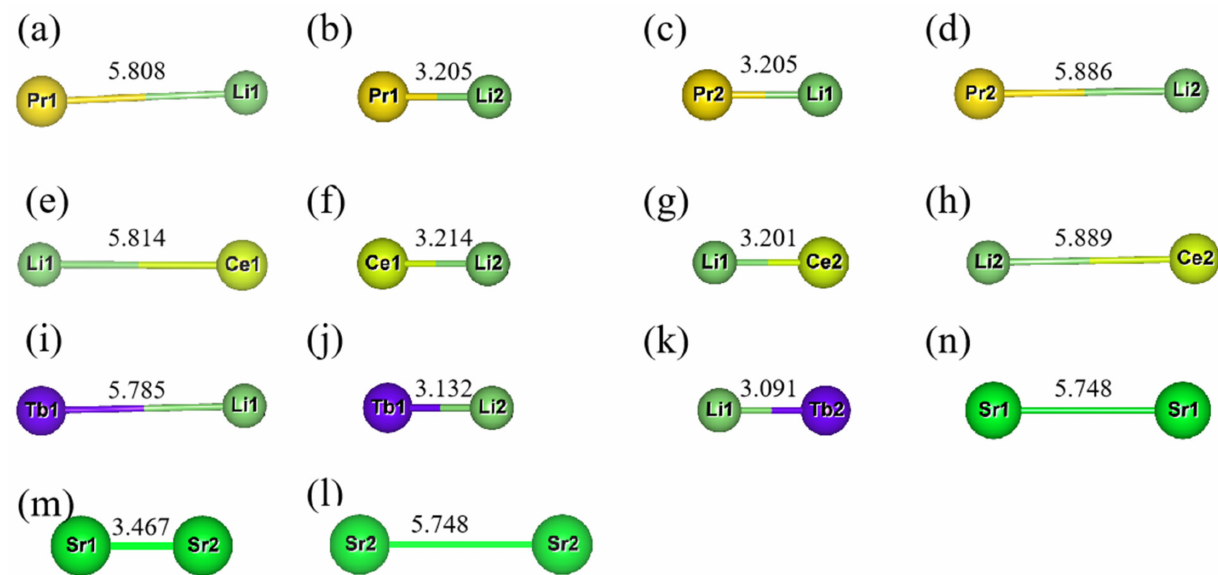
Figure 2. The distance change after Ln 3+ and Li + replace Sr 1 and Sr 2 in doped Sr 2 Si 5 N 8 ( a – k ) Pr Sr1 Li Sr1 -Sr 2 Si 5 N 8 , Pr Sr1 Li Sr2 - Sr 2 Si 5 N 8 , Pr Sr2 Li Sr1 -Sr 2 Si 5 N 8 , Pr Sr2 Li Sr2 -Sr 2 Si 5 N 8 , Ce Sr1 Li Sr1 -Sr 2 Si 5 N 8 , Ce Sr1 Li Sr2 -Sr 2 Si 5 N 8 , Ce Sr2 Li Sr1 -Sr 2 Si 5 N 8 , Ce Sr2 Li Sr2 -